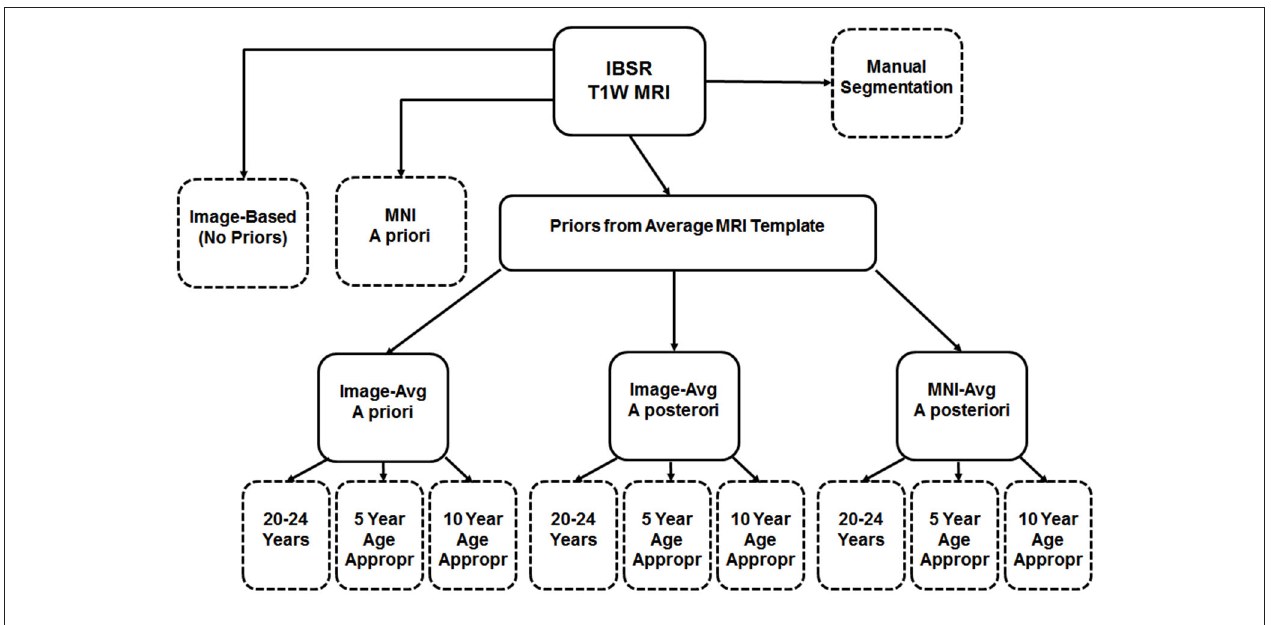
a posteriori using MNI-based averages. Each of these was conducted using priors from three template age groups: a 20–24 year template, a five-year age-matched template, and a 10-year age-matched template. The eleven segmented volumes resulting from this, and the manual segmented volume, are represented with dashed-line